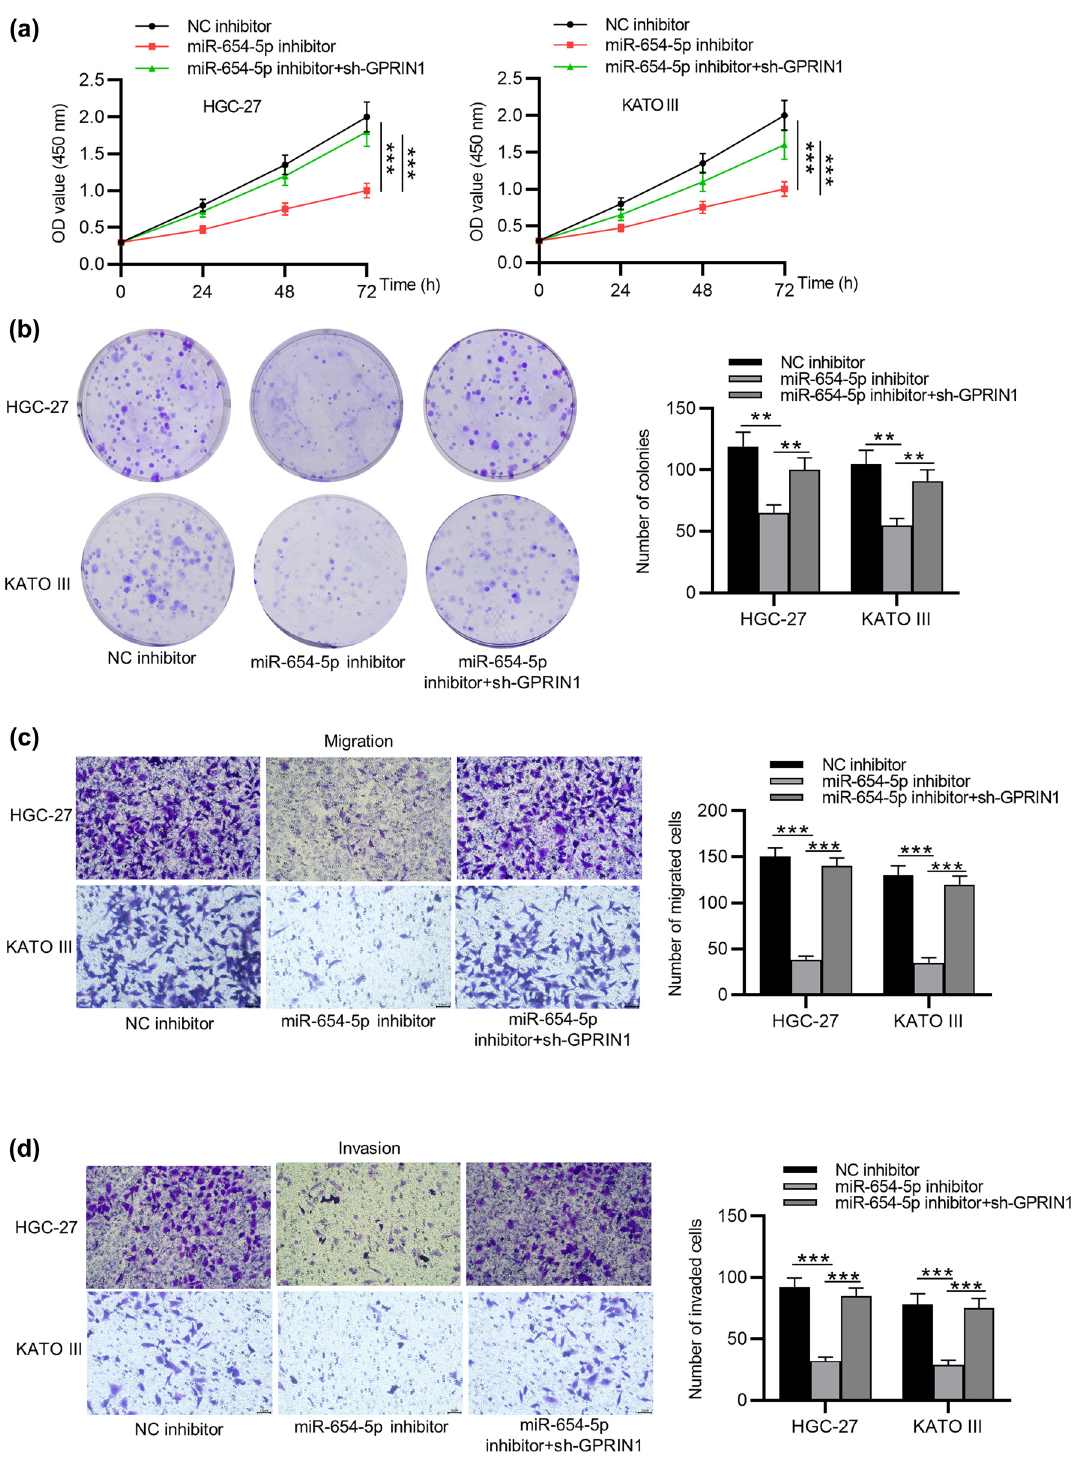
Figure 4: miR - 654 - 5p knockdown inhibits proliferation, migration, and invasion of GC cells by GPRIN1. ( a – d ) CCK - 8, colony formation, and Transwell assays revealed that GPRIN1 knockdown rescued the inhibition in the proliferation, migration, and invasion of HGC - 27 and KATO III cells caused by miR - 654 - 5p inhibitor. ** p < 0.01, *** p <